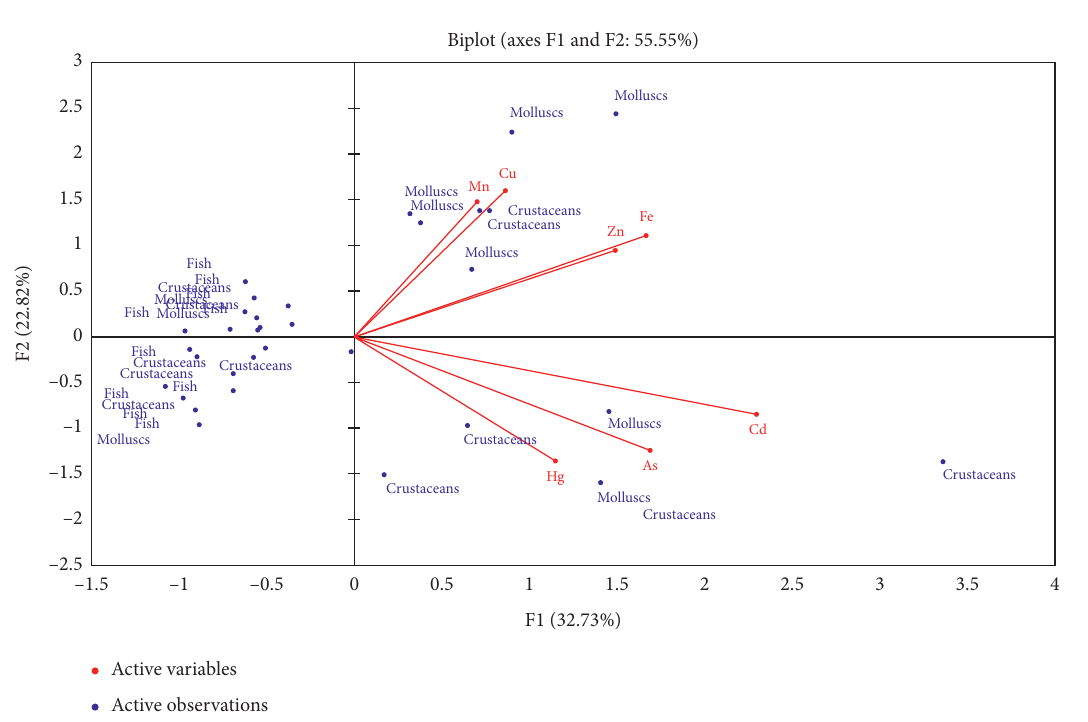
Figure 3: PCA analysis of 7 trace metal elements in 35 observed samples in the coastal zone of the Red River in Thai Binh and Nam Dinh provinces in